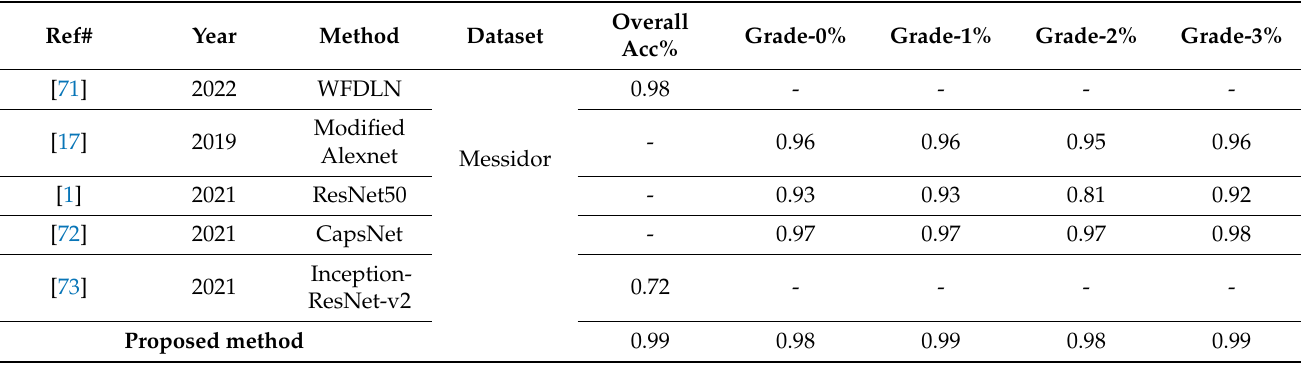
Figure 11. Confidence interval of classification accuracy by performing Monte Carlo simulation on 20 iterations using Messidor dataset. The classification accuracy after 20 cross-fold validation is greater than 0.95. Table 9 presents the comparison results of the classification methods. Table 9. Comparison of classification results.